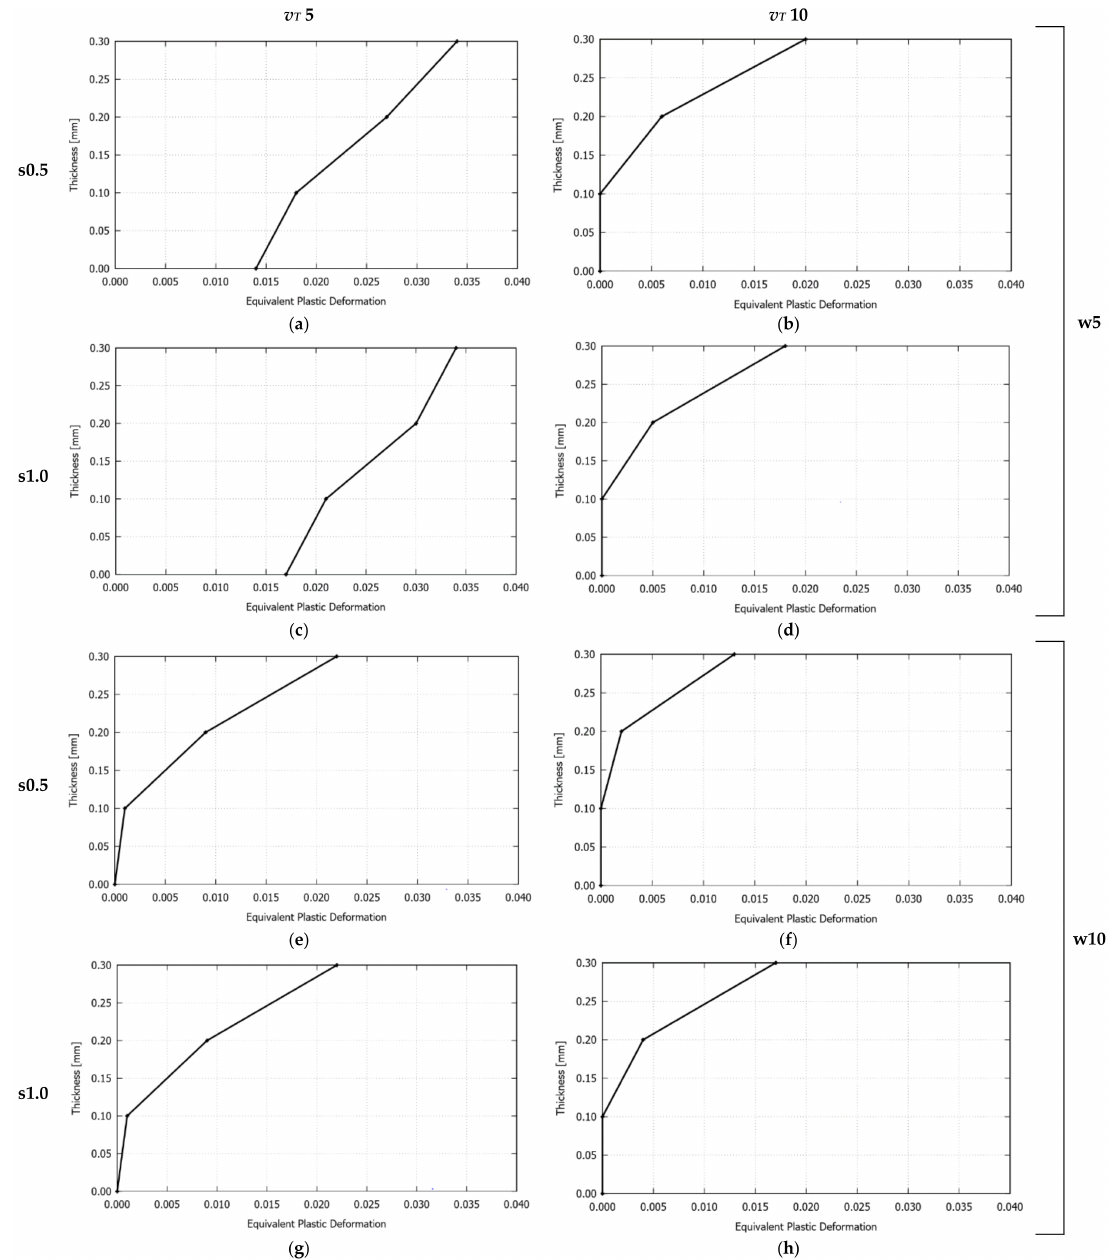
Figure 11. Single S-shape scanning path. Computed equivalent plastic deformation profile along the thickness of the plate at the middle point of the laser path for the studied cases. ( a ) v T = 5 mm/s, s = 0.5 mm, w = 5 mm; ( b ) v T = 10 mm/s, s = 0.5 mm, w = 5 mm; ( c ) v T = 5 mm/s, s = 1.0 mm, w = 5 mm; ( d ) v T = 10 mm/s, s = 1.0 mm, w = 5 mm; ( e ) v T = 5 mm/s, s = 0.5 mm, w = 10 mm; ( f ) v T = 10 mm/s, s = 0.5 mm, w = 10 mm; ( g ) v T = 5 mm/s, s = 1.0 mm, w = 10 mm; ( h ) v T = 10 mm/s, s = 1.0 mm, w = 10